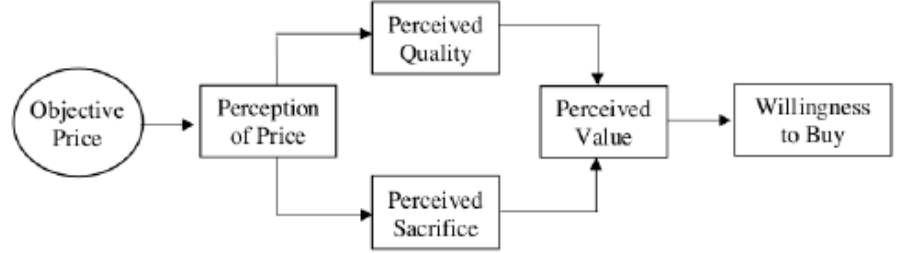
Figure 1. Price-value model proposed by Monroe and Krishman (1985) [35].